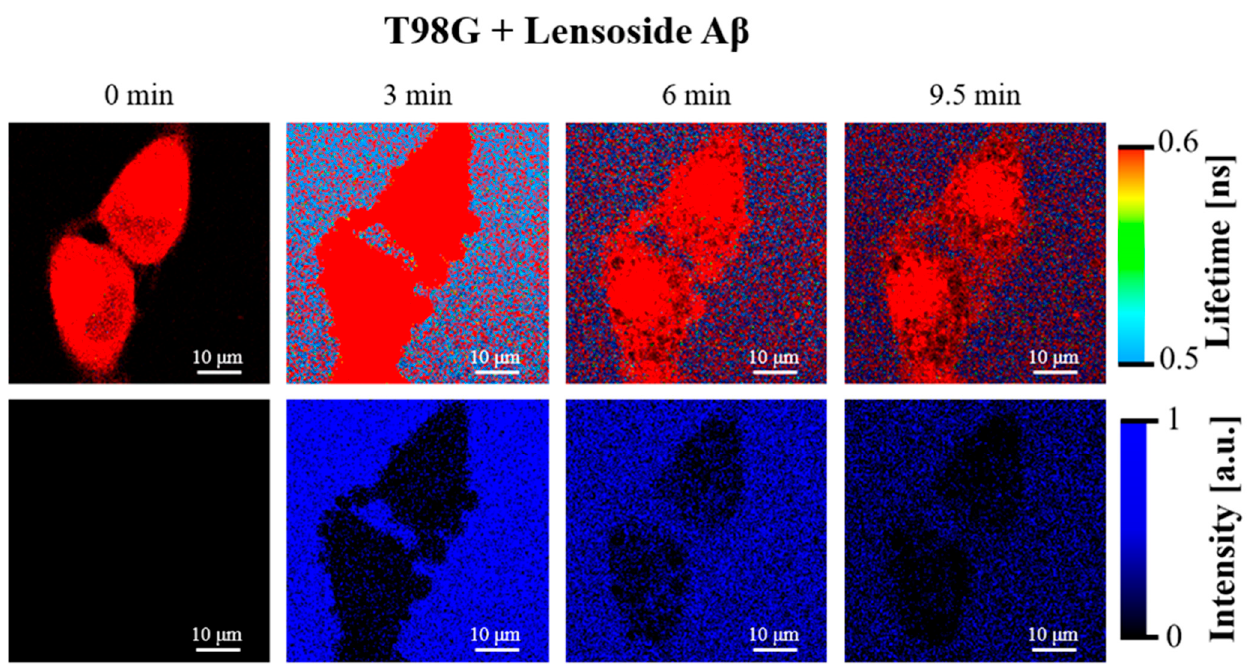
Figure 13. FLIM images of the T98G cells incubated with lensoside A β for the indicated different periods. The lower panel presents the same images created solely on the fluorescence lifetime component of 0.01 ns, representing selectively lensoside A β and showing its distribution in the examined system. See also Figure S3 for images of the other cells. Note a pronounced cell membrane deformation in the first 3 min of incubation.